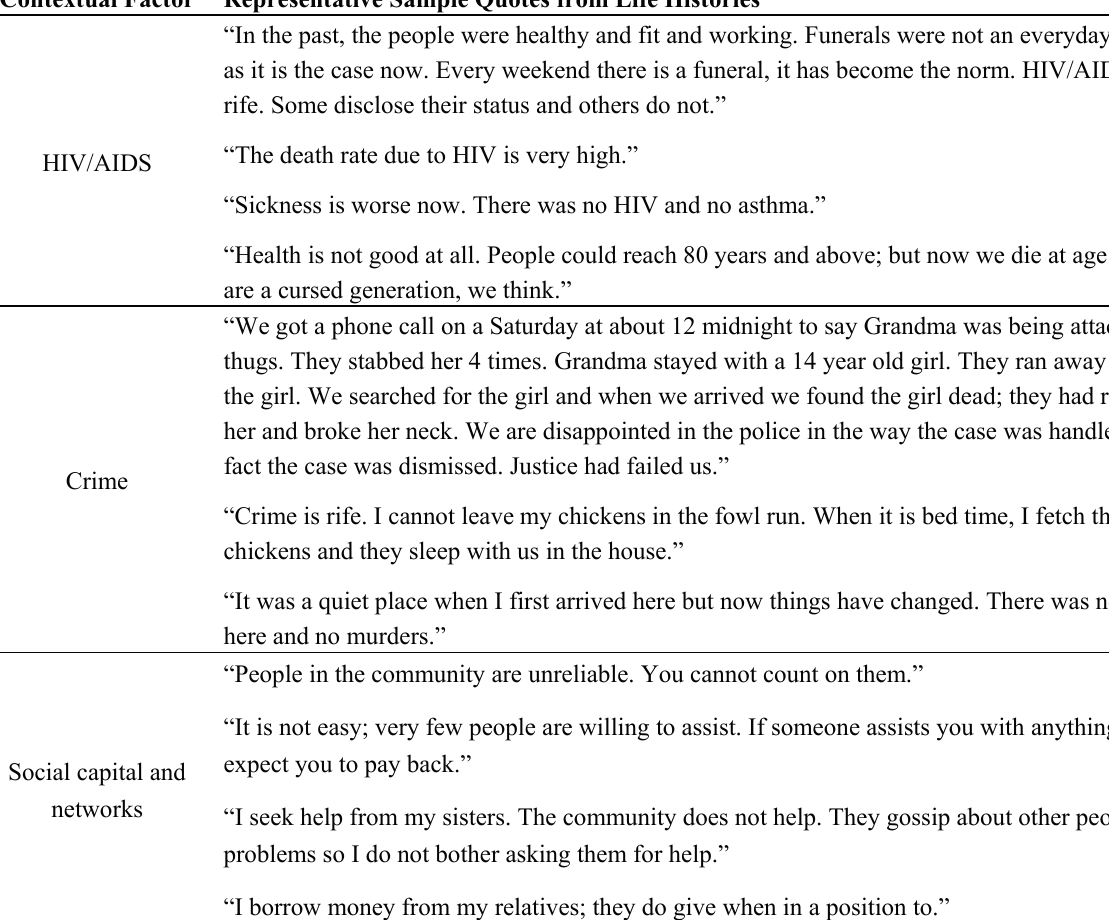
Table 7. Narratives from the life histories (n = 20) suggesting the long-term impacts of HIV/AIDS, crime, and the erosion of social capital, but also how family still tries to assist in times of